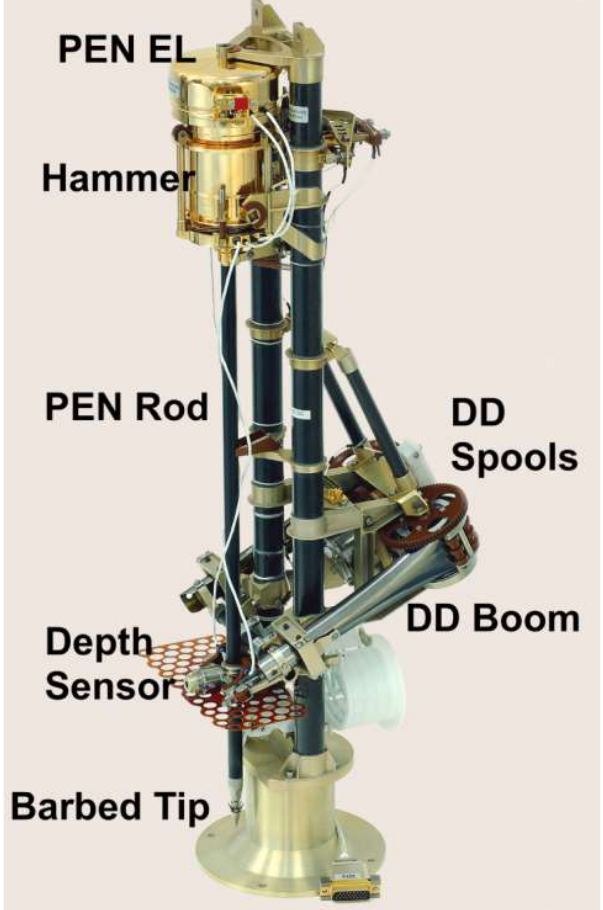
Figure 7. The MUPUS PEN with the deployment device in the stowed position on the lander (cruise configuration). From top to bottom, the figure shows the front-end electronics PEN-EL, the hammer mechanism, the PEN rod in which the temperature sensors are implemented, the deployment device spools and boom, the depth sensor, and the barbed tip of the PEN. The PEN is mounted to two struts that are bolted onto the top of the APX housing. The red perforated plate is a SESAME PP electrode and is not part of the MUPUS package. The diameter of the PEN is 10 mm, and the diameter of the hammer head is ~70 mm. Image courtesy of J. Knollenberg.